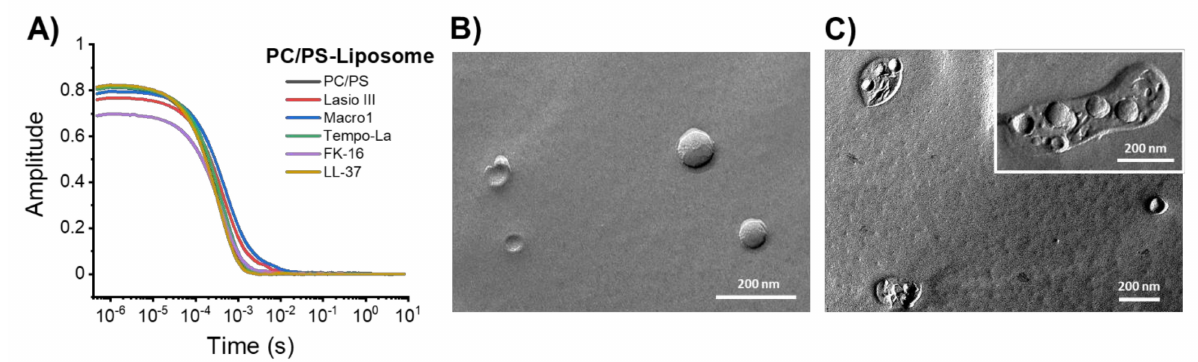
Figure 4. Size and morphology variations of the vesicles induced by the ACPs. ( A ) Correlation function by DLS for the studied ACPs in the presence of the lipid membrane PC/PS; peptide and lipid concentrations are 40 and 635 µ M for all the peptides, except for LL-37, which is 20 and 320 µ M, respectively. Freeze fractured TEM images of ( B ) PC/PS-alone; lipid concentration 2540 µ M and ( C ) LL-37-PC/PS mixture; peptide and lipid concentration are 80 and 2540 µ M,